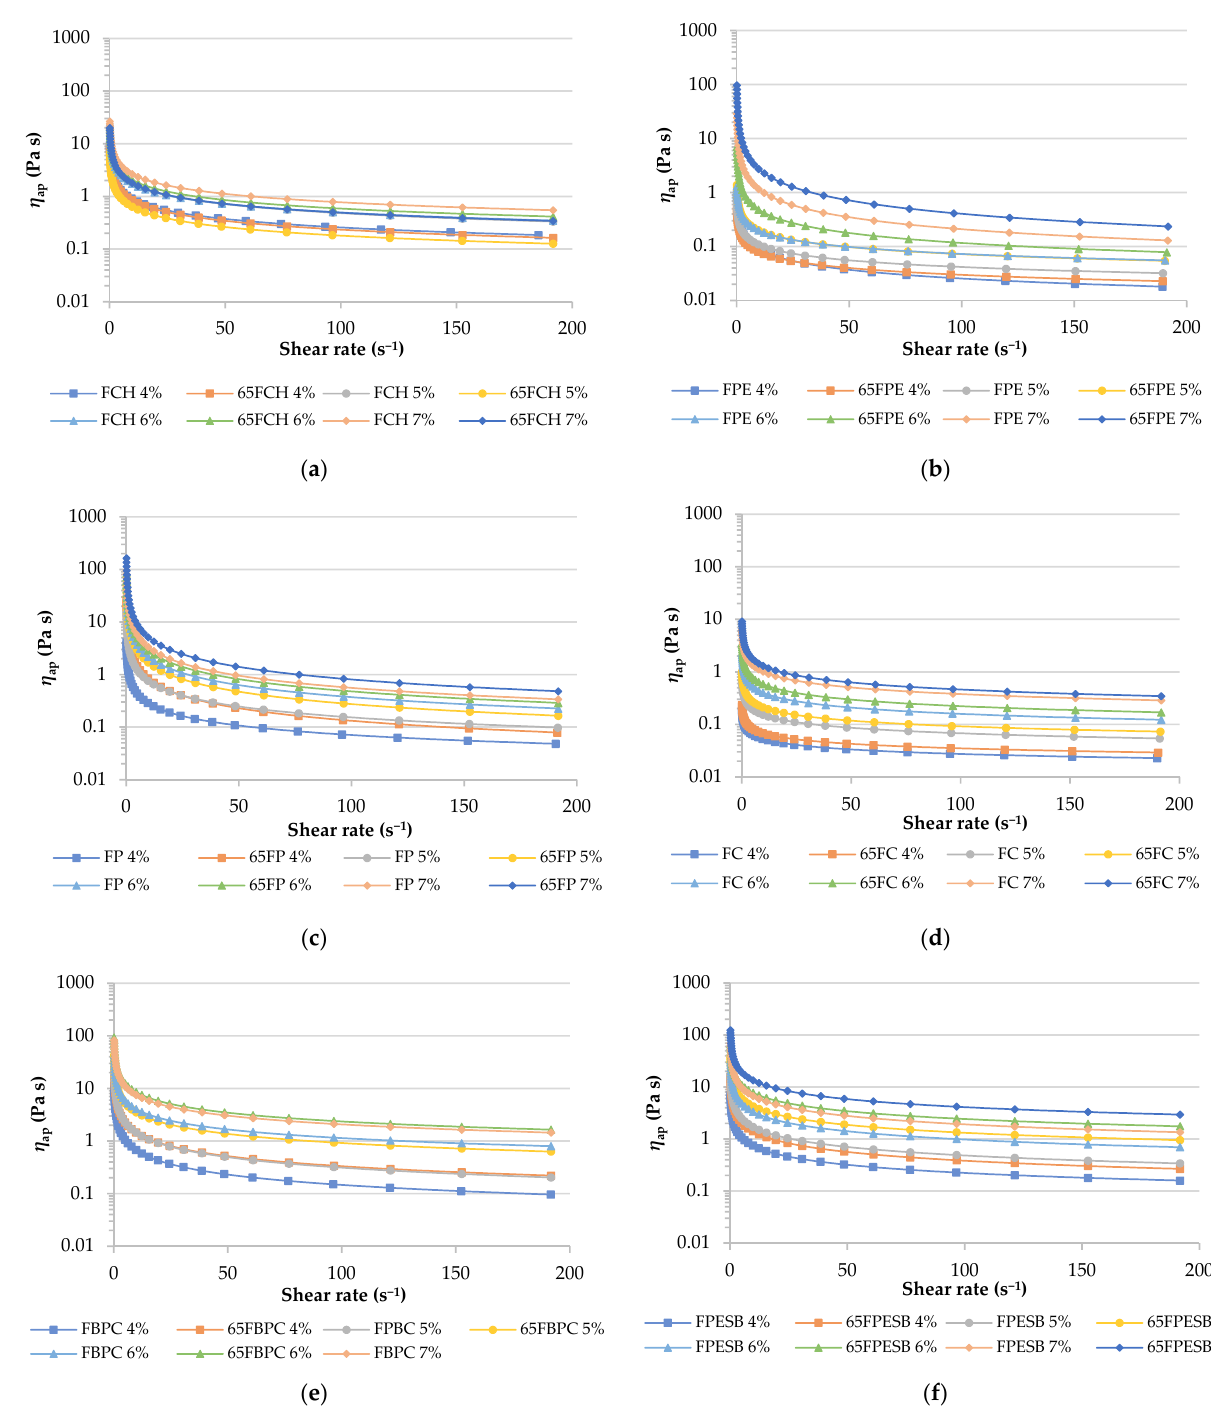
Figure 6. Apparent viscosity ( η ap ) vs. the shear rate of samples, where ( a ) shows the FCH, ( b ) FPE, ( c ) FP, ( d ) FC, ( e ) FBPC and ( f ) FPESB sample gels.